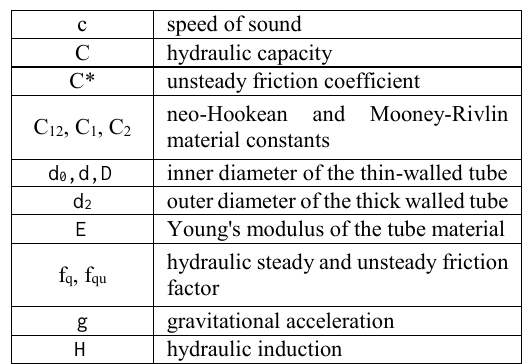
Table 2. List of symbols.